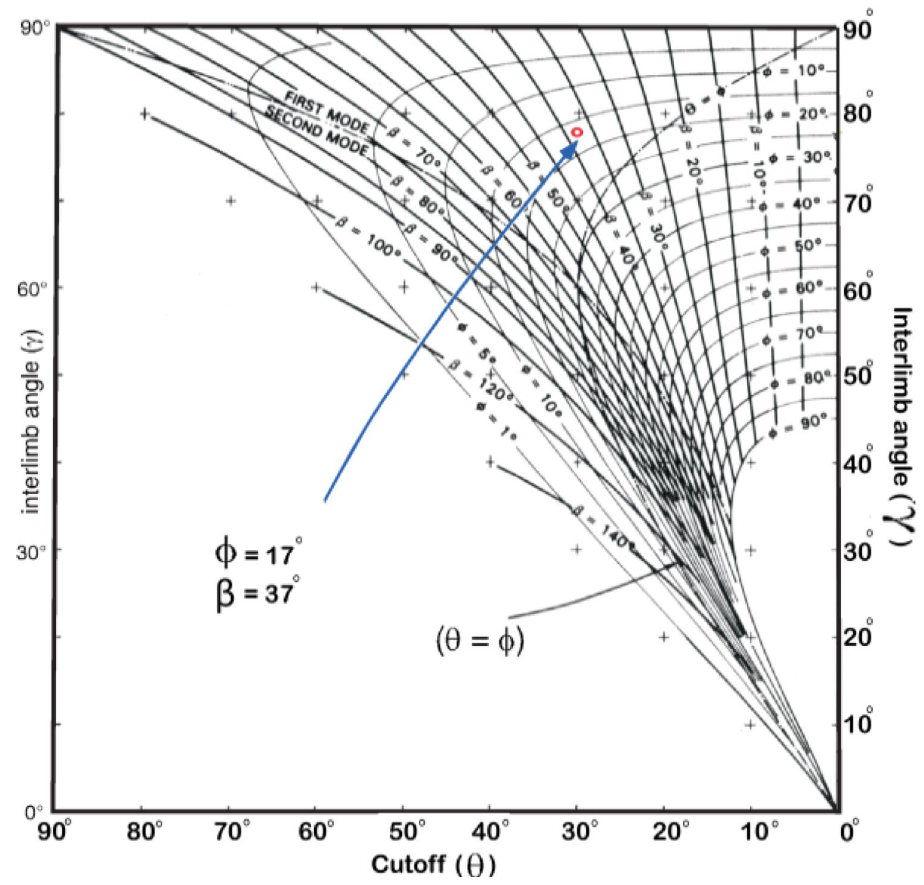
Fig. 12 Graph showing the relationship between the cutoff angle and inter limb angle as function to calculate the change of fault dip and cutoff after pending for anticlinal fault-bend